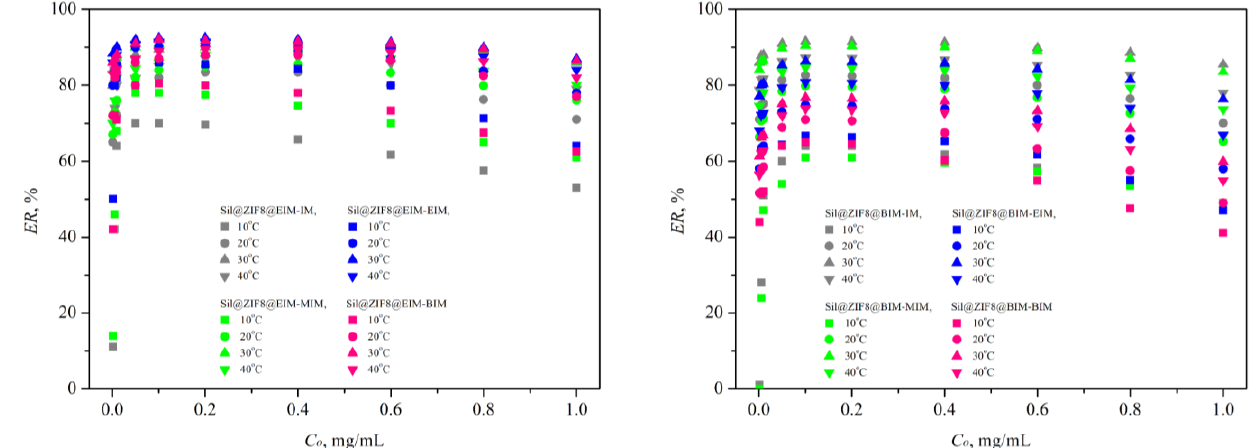
Figure 4. The adsorption efficiencies of four Sil@ZIF8@BIM-IL sorbents and four Sil@ZIF8@EIM-IL sorbents.